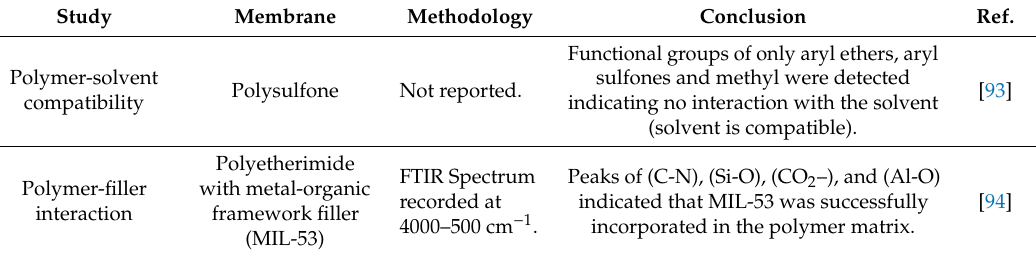
Table 7. FTIR studies for characterization of polymeric